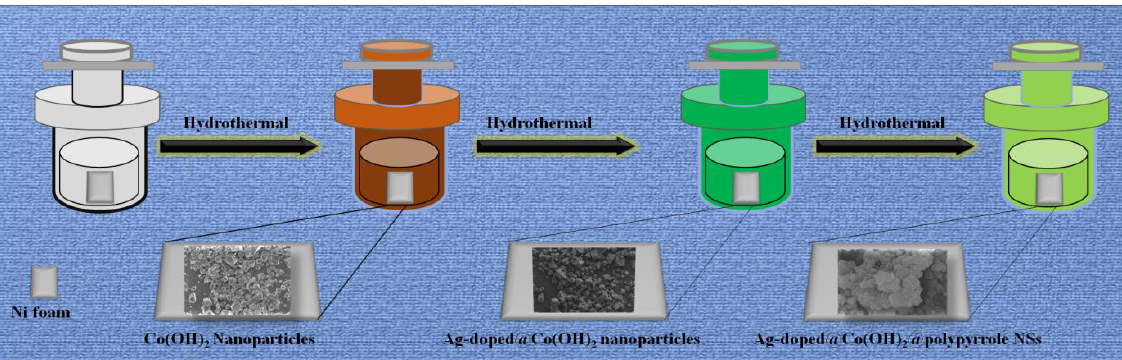
Figure 1. Schematic illustration of the synthesis of Ag-doped@@Co(OH) 2 @polypyrrole NSs.